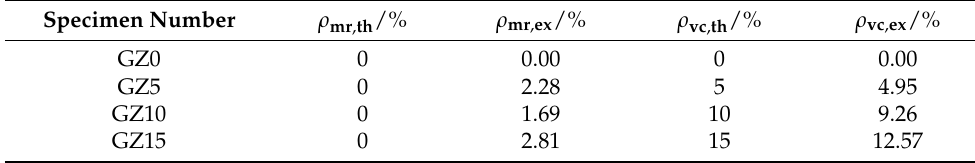
Table 2. Corrosion rates of reinforcing steel bars in columns.